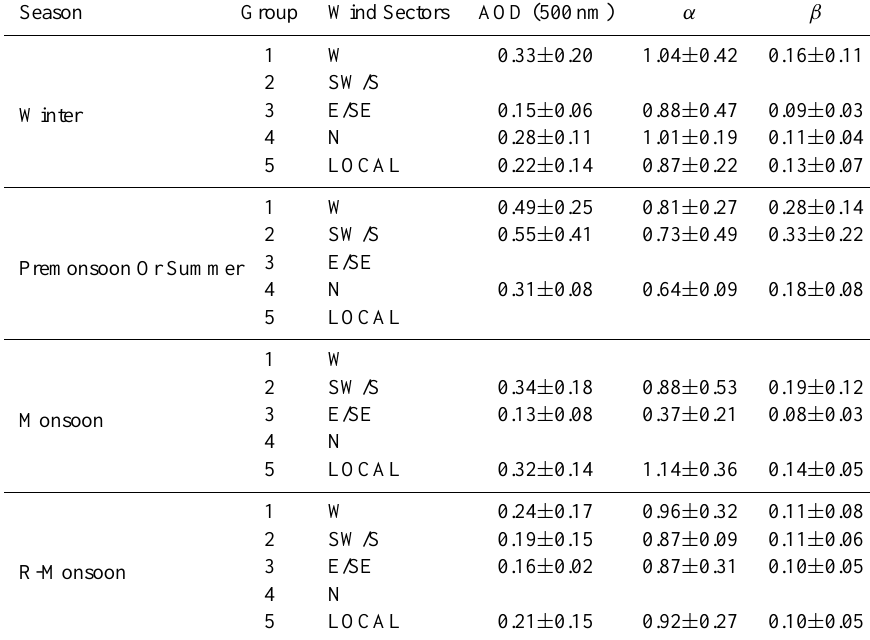
Table 3. Distribution of AOD, α and β with respect to different trajectory